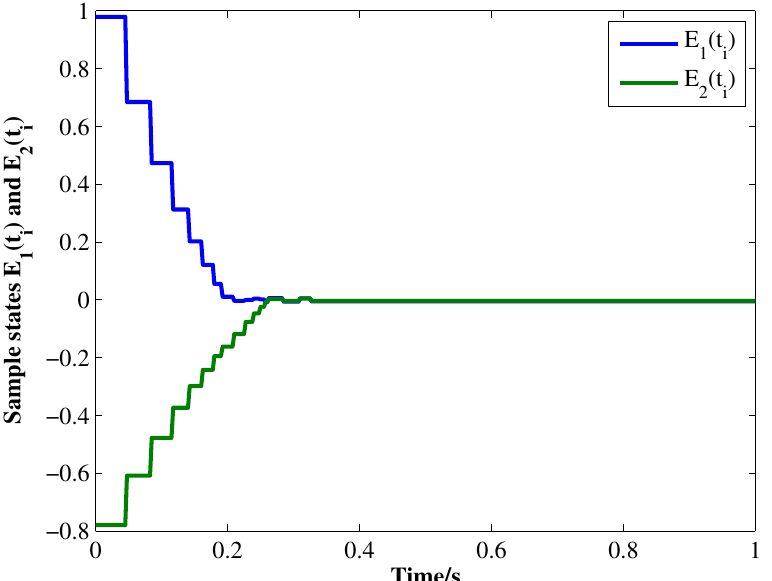
Figure 4. Sample errors E 1 ( t i ) and E 2 ( t i ) between systems (33) and (34) under ETC condition (39) with η = 0.5.